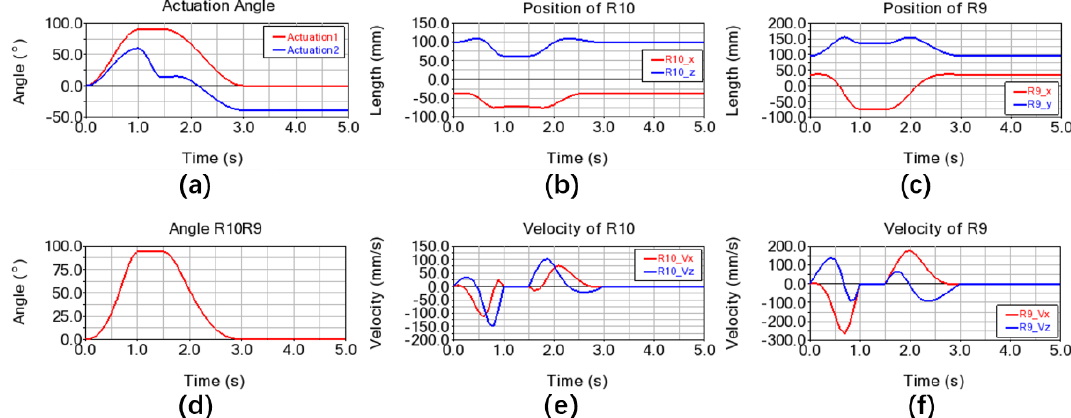
Figure 10. (a) The rotation actuated on the R 1 and R 8 related to the swimming cycle mimicking a frog’s swimming locomotion. (b) The position components in the x and y directions of R 10 . (c) The position components in the x and y directions of R 9 . (d) The rotation of link R 10 R 9 . (e) The velocity components in the x and y directions of R 10 . (f) The velocity components in the x and y directions of R 9 .